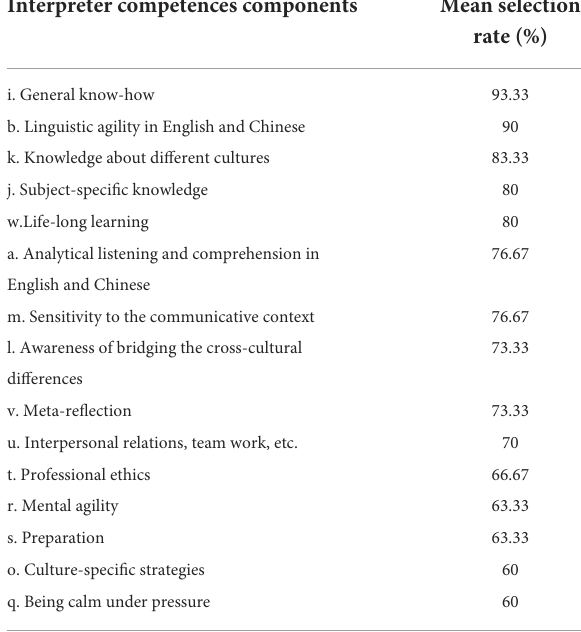
TABLE 10 Frequently selected components which contributed to development of career adaptability.